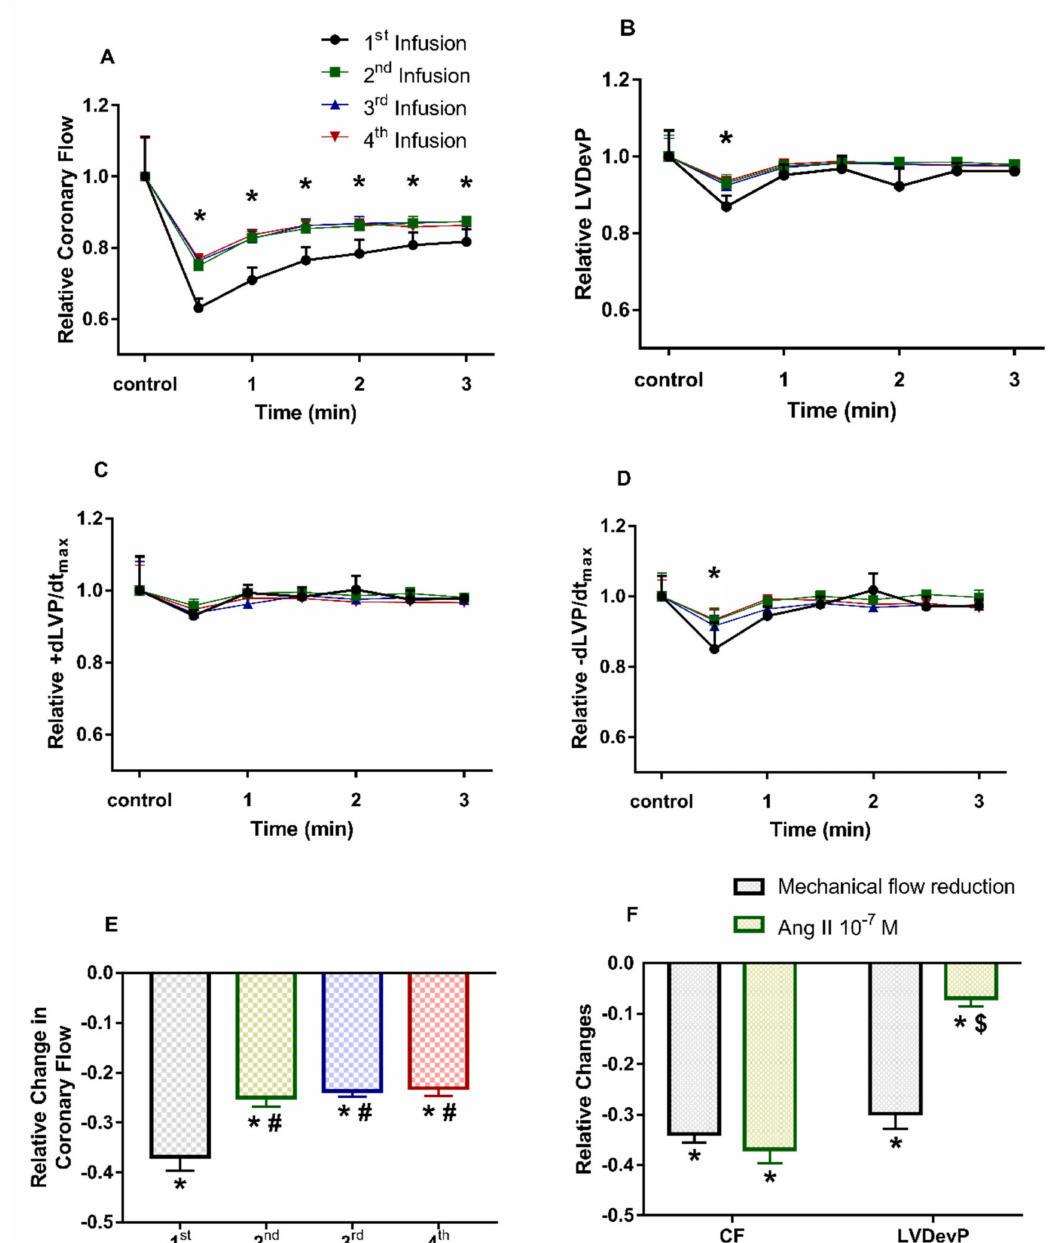
Figure 3. Effects of repetitive angiotensin II (Ang II) infusion on coronary flow ( A ), left ventricular developed pressure (LVDevP) ( B ), +dLVP/dt max ( C ) and − dLVP/dt max ( D ) of isolated rat hearts. Maximal decrease in coronary flow during repetitive infusion periods ( E ). Decrease in LVDevP when the coronary flow is reduced either mechanically by compressing the perfusion line (grey) or by the vasoactive effect of Ang II (green) ( F ). Ang II (10 − 7 M) was administered repetitively to the perfusate of isolated rat hearts ( A – E ). Each Ang II infusion period lasted for 3 min and was followed by a 10-min wash-out period. Mean ± SEM; n = 4; * p < 0.05 vs. control (pre-infusion value) in each group; one-way repeated measurement ANOVA and Dunnett’s post-hoc test; # p < 0.05 vs. first infusion period; one-way ANOVA and Dunnett’s post-hoc test; $ p < 0.05 vs. relative decrease in coronary flow, paired t